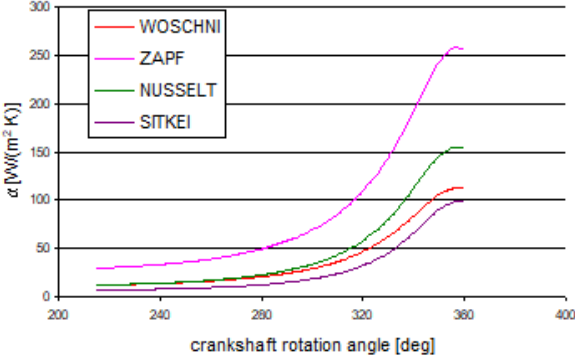
Fig. 1. The dependence of surface film conductance value on crankshaft rotation angle in AD4.236 engine compression chamber computed accord- ing to the formulae of: Zapf, Nusselt, Woschni,